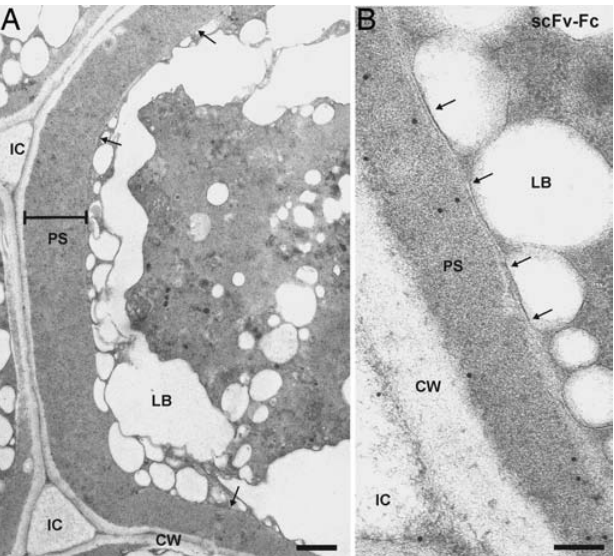
Fig. 2. Localization of scFv-Fc in imbibed transgenic Arabidopsis seeds. ( A ) Overview of a storage parenchyma cell in the cotyledon. A striking feature is the presence of an extensive electron opaque layer (PS) between the cell wall (CW)andtheplasmamembrane(arrows).( B )Highmagnificationshowingthe immunogold (15-nm) detection of scFv-Fc molecules in the PS. LB, lipid body; IC, intercellular space. (Scale bars: A , 750 nm; B , 150 nm.)